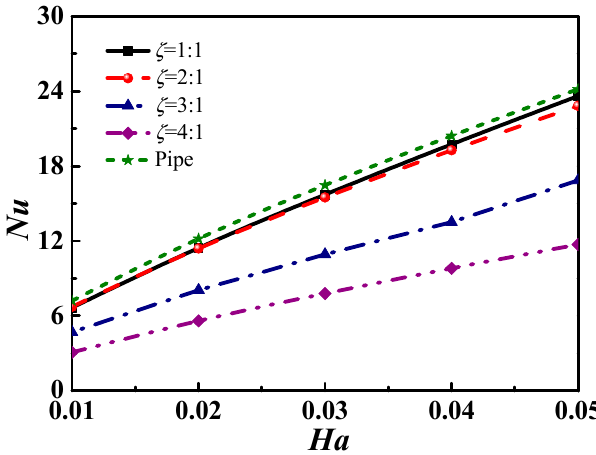
Figure 5. The Nu number varies with Ha number in microchannels with different cross-sectional shapes.